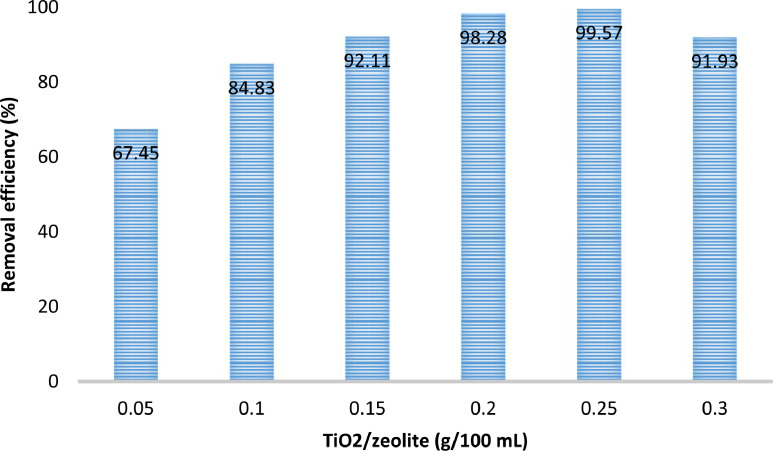
Effect of TiO2/zeolite dosage on AO10 dye removal (dye concentration = 20 mg/L, pH = 3, contact time = 7 min,).